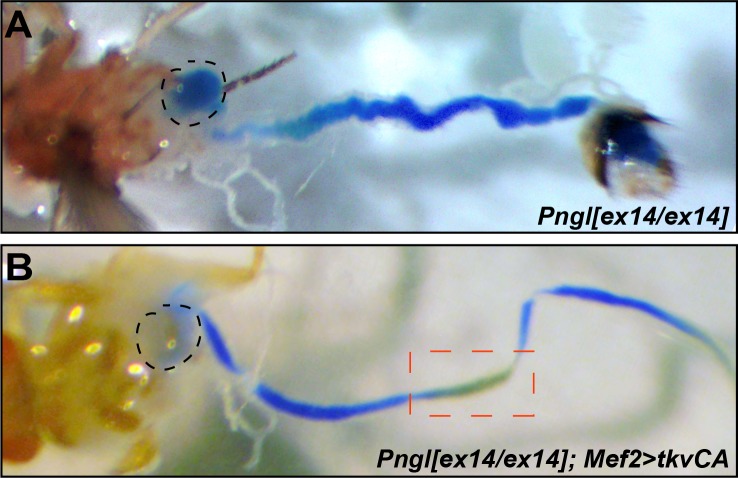
The acid zone impairment in adult midgut of Pngl mutant flies can be rescued by overexpressing tvkCA in the mesoderm.(A–B) Bright field images of midguts from adult flies of the indicated genotypes fed with food containing bromophenol blue. The acid zone is delimitated by the red dotted boxes. The dashed circles indicate the crop.